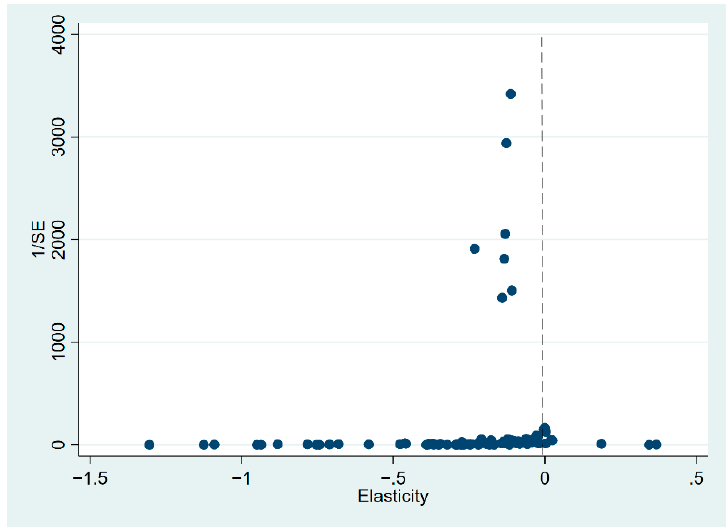
Figure 3. Funnel plot.